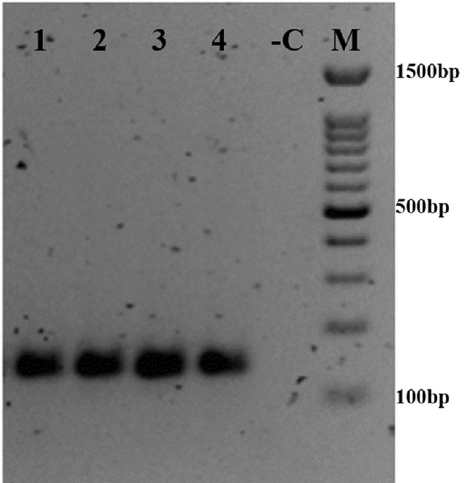
Figure 5. Clinical samples evaluation by universal OFRV primers. Electrophoresis gel showing the PCR amplicon of four suspected ORFV clinical samples collected from Black Bengal goats. M: 100 bp DNA ladder; -C: Negative control (PCR using nuclease-free water as DNA template); 1–4: Clinical samples.